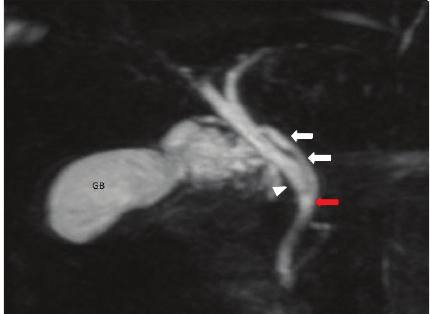
Figure4:Coronaloblique3DMRcholangiopancreatographyshows parallel course of cystic duct (white arrow) and CHD (white arrowhead). Also note medial insertion of cystic duct (red arrow). GB: gall bladder.